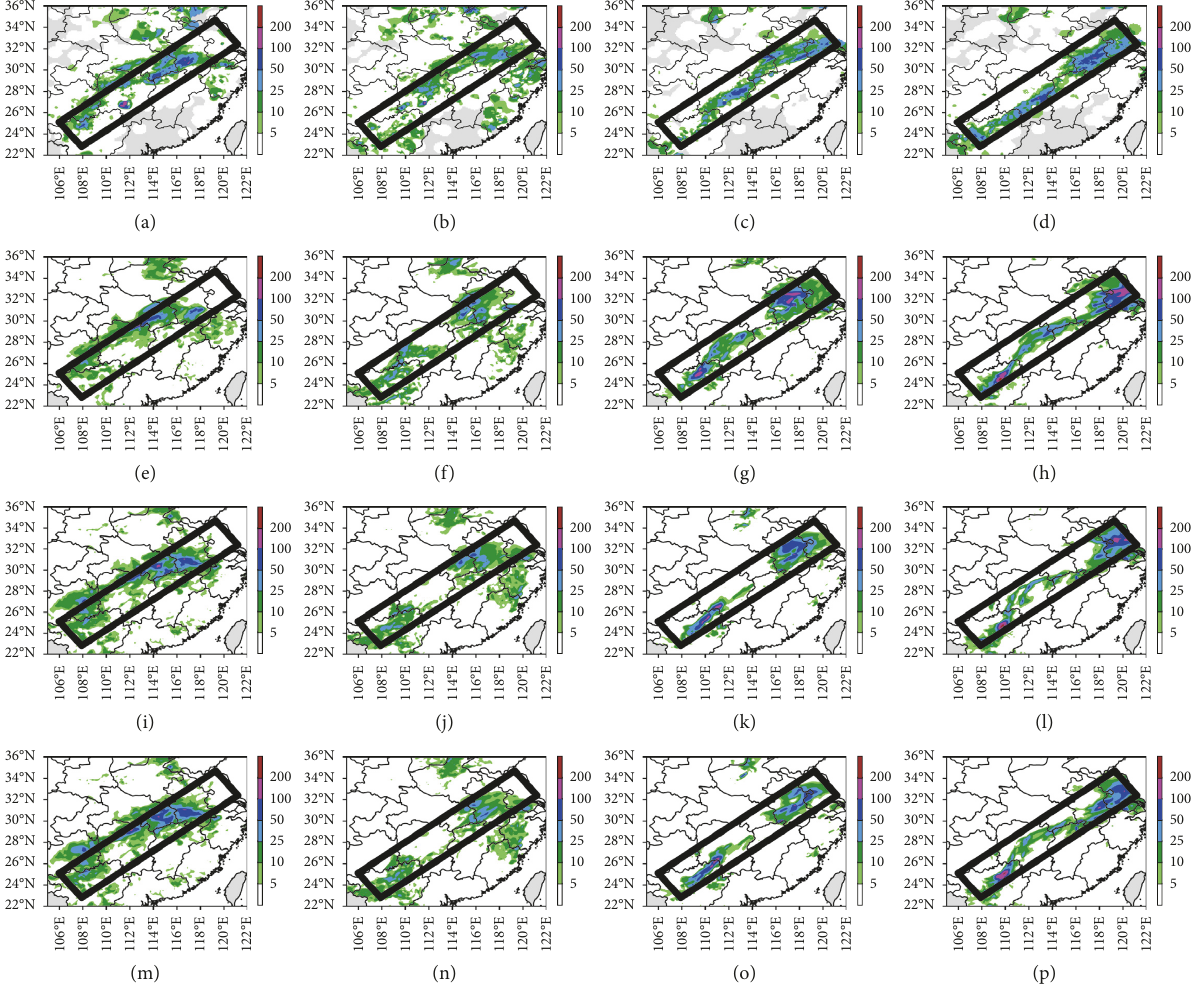
Figure 4: Six-hour accumulated precipitation from 0000 to 0600 UTC ((a) observations, (e) CON, (i) RAD, and (m) RADC) and from 0600 to 1200 UTC ((b) observations, (f) CON, (j) RAD, and (n) RADC), from 1200 to 1800 UTC ((c) observations, (g) CON, (k) RAD, and (o) RADC), and from 1800 UTC 4 July to 0000 UTC 5 July 2014 ((d) observations, (h) CON, (l) RAD, and (p) RADC) (unit: mm). The black solid squares represent the main rain